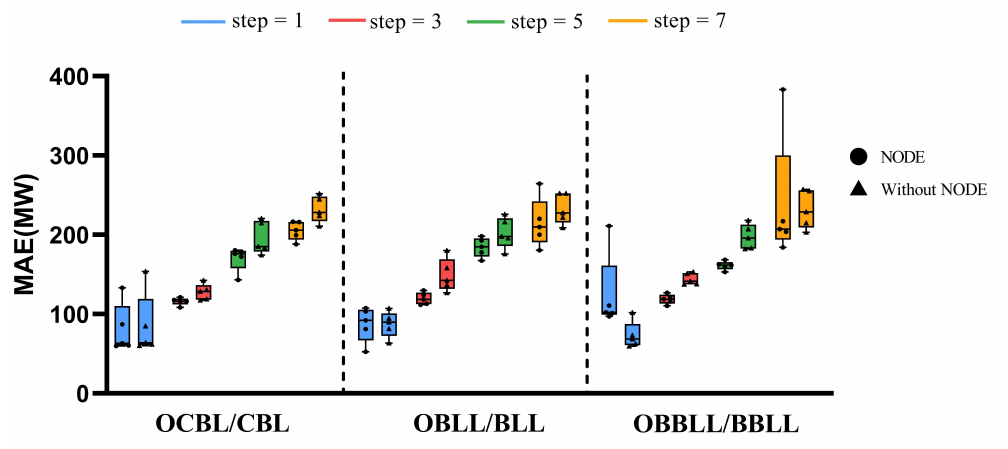
Figure 10. The MAPE metric comparison of three groups of models, respectively, in future steps 1, 3, 5, and 7 in Queensland in 2019. The dotted line divides the different comparative model groups. In each comparative model group, different colors represent different steps. The model with NODE is on the left side and the model without NODE is on the right side.